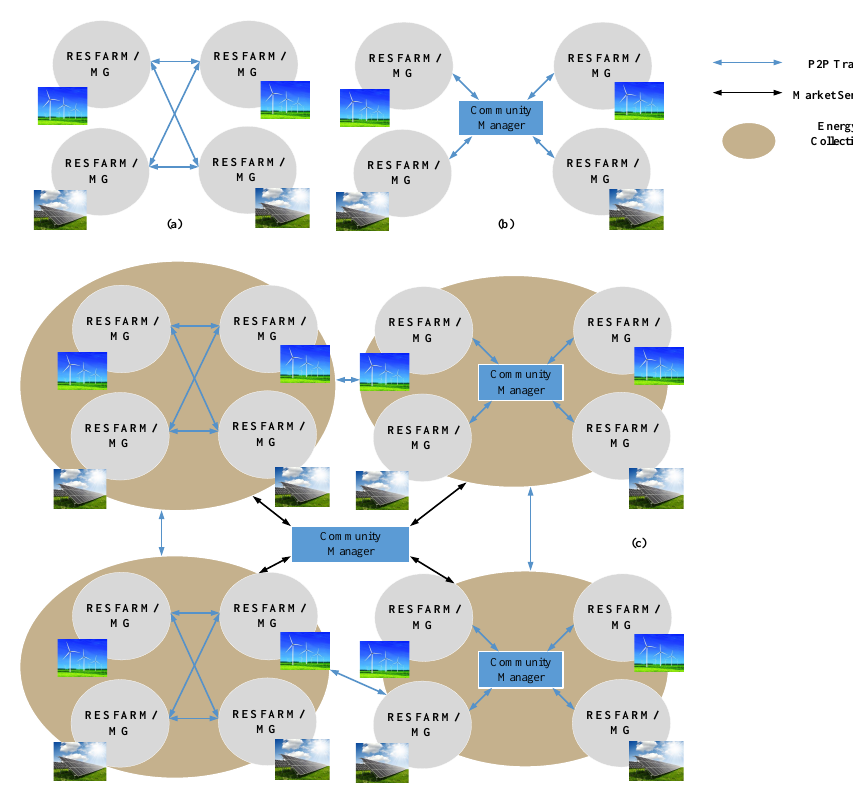
Figure 5. ( a ) P2P energy market, ( b ) Community-based P2P energy market, and ( c ) Hybrid P2P energy market